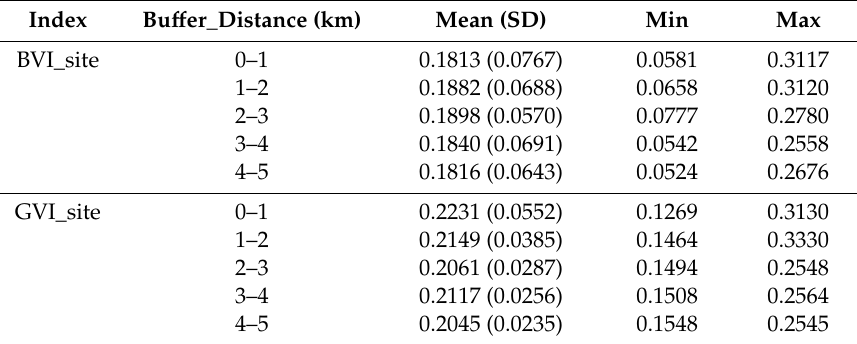
Figure 5. Spatial distribution of GVI_sample and BVI_sample (values between 0~1). ( a ) Beijing, BVI; ( b ) Nanjing, BVI; ( c ) Shanghai, BVI; ( d ) Beijing, GVI; ( e ) Nanjing, GVI; ( f ) Shanghai, GVI. Table 3. Descriptive statistics of BVI_site and